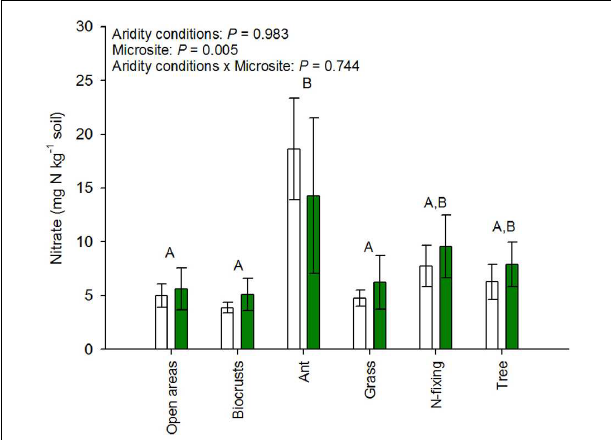
FIGURE 3 | Nitrate availability in the different microsites studied. Data are mean ± SE, n = 12 and 9 for arid and mesic ecosystems, respectively. Upper case letters indicate differences between microsites (Tukey post hoc test after